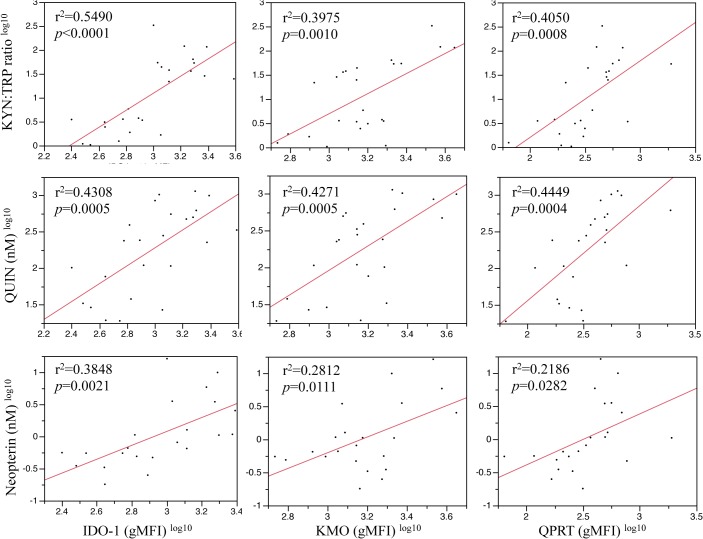
Correlations of IDO-1, KMO and QPRT expression (gMFI) with KYN:TRP ratio, QUIN concentration (nM) and neopterin levels (nM).Data was log10 transformed to normalize distributions. Straight-line fits show least squares regression with the r2 value providing a summary of fit. P values were computed using ANOVA for a regression analysis of the total variation for each correlation (n = 24).